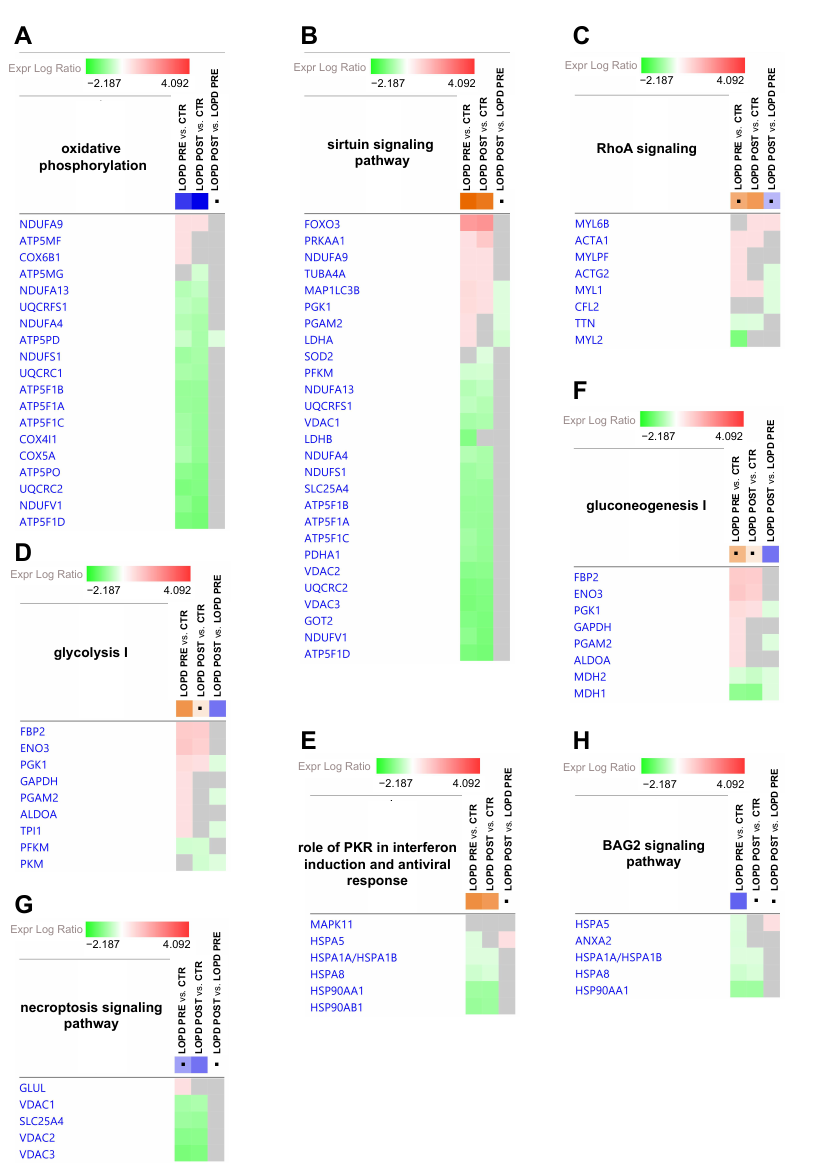
Figure 4. Gene heatmap enables to visualize protein expression data in a specific canonical pathway, across multiple analyses at one time. ( A ) Oxidative phosphorylation. ( B ) Sirtuin signaling pathway. ( C ) RhoA signaling. ( D ) Glycolysis I. ( E ) Role of PKR in interferon induction and antiviral response. ( F ) Gluconeogenesis I. ( G ) Necroptosis signaling pathway. ( H ) BAG2 signaling pathway. Green and red colors refer respectively to decrease or increase for each individual protein statistically changed in our proteomics dataset. Grey color indicates changes that are statistically not significant for p -value (ANOVA followed by Tukey’s post-hoc test ( p < 0.05)). Dots indicate non-significant values for z-score (z-score ≥ 2, ≤ −